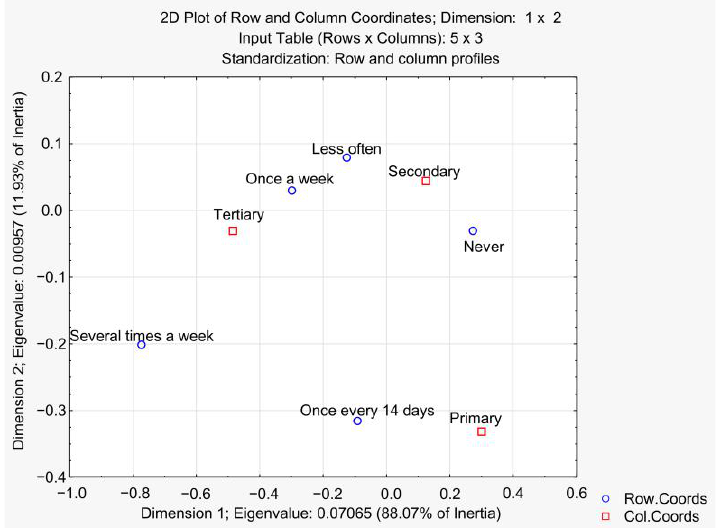
Figure 8. Correspondence maps, Markets and farmers’ markets & Respondent’s education. Source: authors.